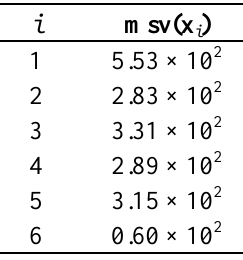
Table 1. Mean square values (msv) of the test deviations x Only msv(x ) exceeds the maximal acceptable value of 5.42 × 10 2 , indicating improper 1 motion in test swing